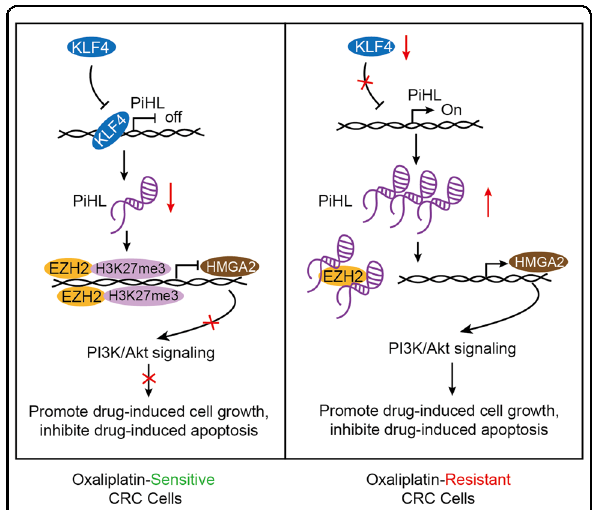
Fig. 7 A proposed schematic model of PiHL regulating oxaliplatin resistance in CRC. KLF4 Krüppel-like factor 4, PiHL P53 inHibiting LncRNA, EZH2 Enhancer of zeste 2, H3K27me3 methylation of histone H3 lysine 27, HMGA2 highmobility group A2, CRC colorectal